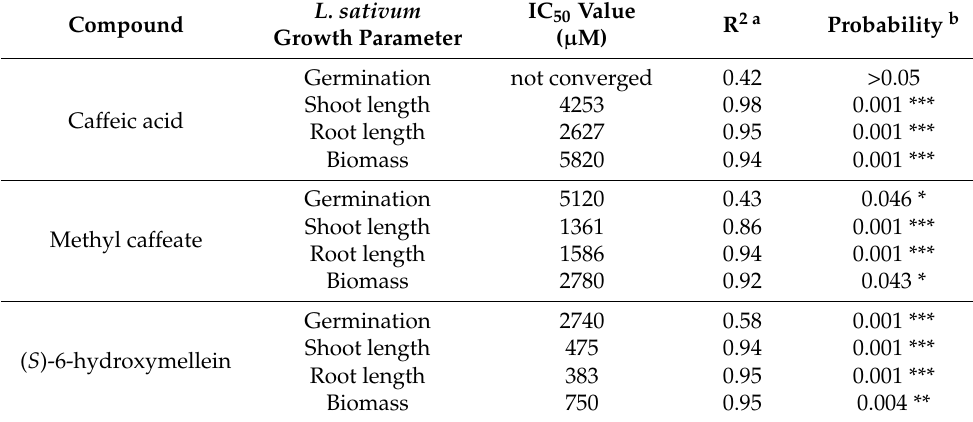
Table 1. The IC 50 values of caffeic acid, methyl caffeate, and ( S )-6-hydroxymellein for the seed germination, seedling growth, and biomass of L. sativum